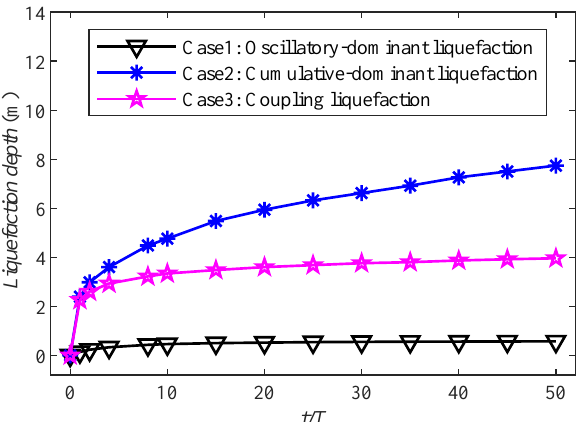
Figure 13. Comparison of the maximum liquefaction depth versus wave cycles in three